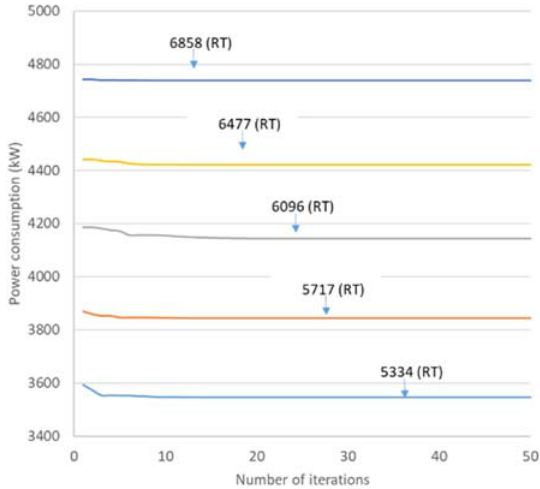
Figure 4. Power consumptions of chillers in Case 1 operated by TPSO algorithm.